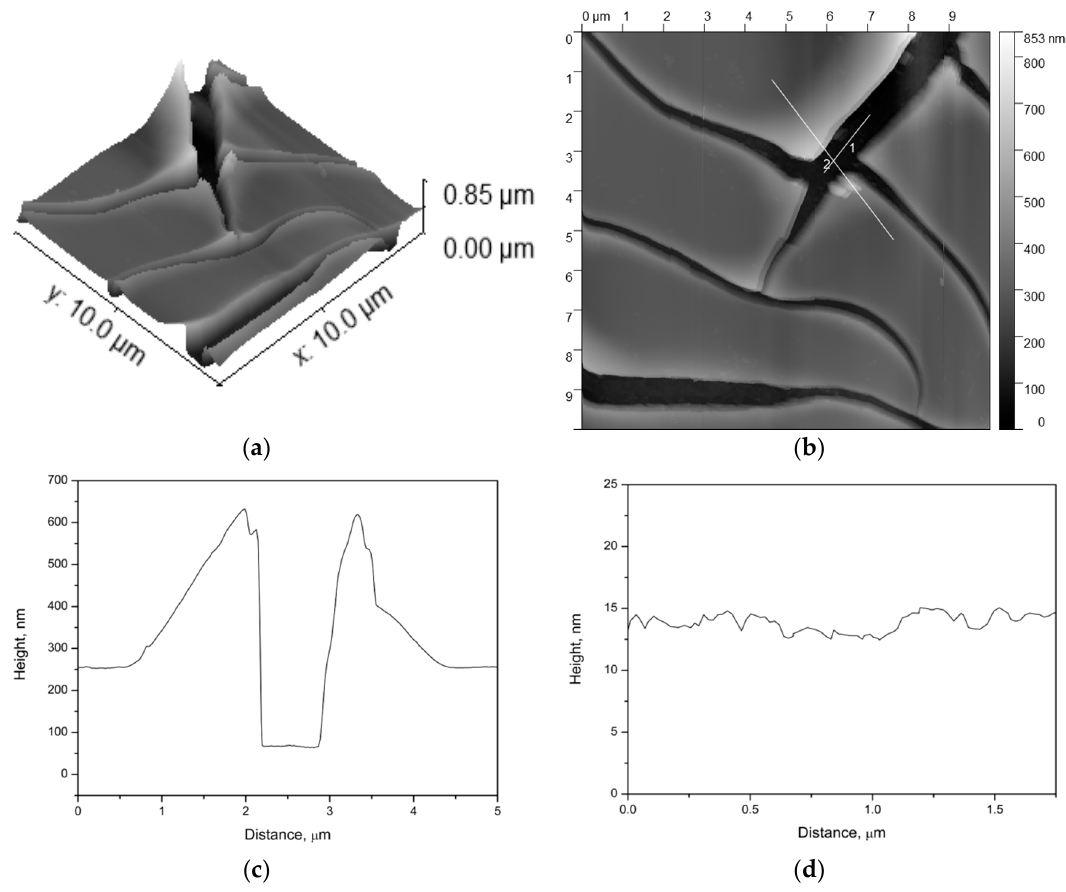
Figure 3. AFM image of the sample after 4 cycles of dip coating ( a —3D model; b —frontal view with the lines of profile building; c —profile 1; d —profile 2).